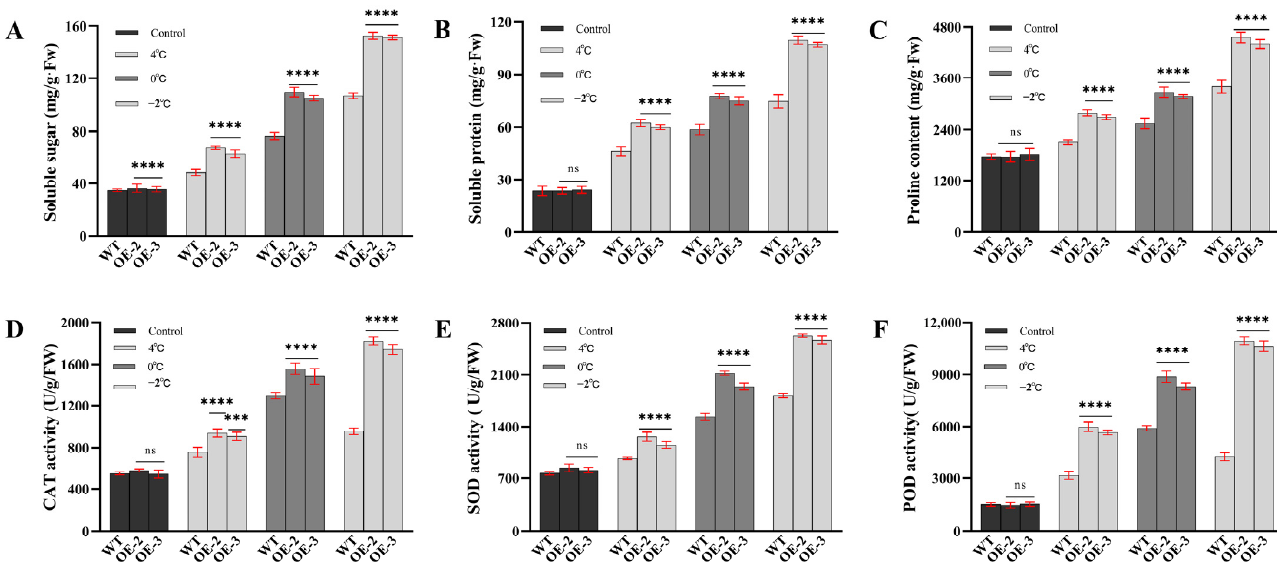
Figure 3. Accumulation of osmotic regulators and change in antioxidant enzyme activity in transgenic tomato. ( A ) Soluble sugar content. ( B ) Soluble protein content. ( C ) Proline content. ( D ) CAT activity. ( E ) SOD activity. ( F ) POD activity. Data are means ± SD of three replicates. Ns indicate no significant difference between the wild-type and transgenic lines. Asterisk(s) indicate significant difference between the wild-type and transgenic plants by Student’s t -tests: *** p < 0.001, **** p < 0.0001.